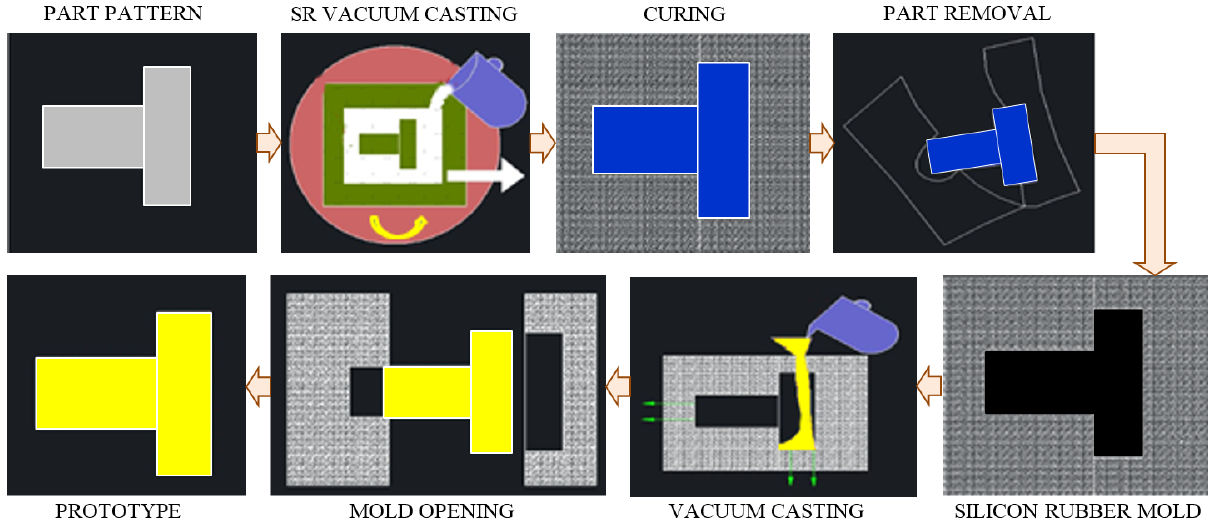
Figure 6. Silicon rubber mold process sequences: part pattern, silicon rubber vacuum casting, curing, part removal, silicon rubber mold, vacuum casting, mold opening and prototype.